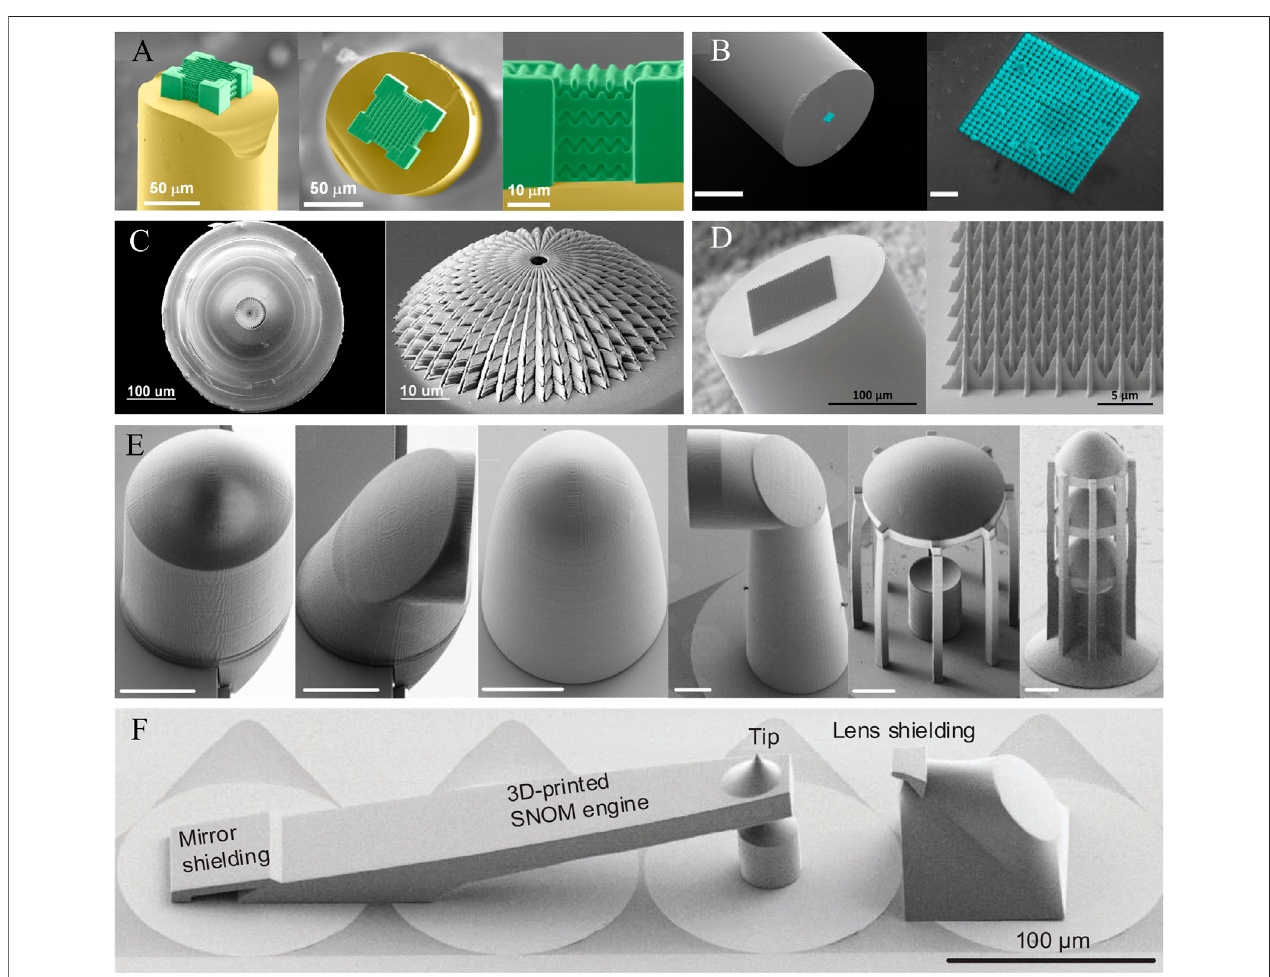
FIGURE 3 | Optical fi ber integrated polymer micro-optics printed by TPP. (A) Woodpile photonic crystal structure printed on the SMF (Williams et al., 2011). (B) Microstructuredgradient-indexantire fl ectivecoatingprintedontheSMFforreducetheFresnelre fl ection(Kowalczyketal.,2014). (C) 3DSERSradarstructureprintedon MMF(Xieetal.,2015). (D) FiberSERSprobewithcrossspikearrayforrapiddetectionoflivebacteria(Kimetal.,2020). (E) Free-formlenses,free-formmirrorsandbeam expanders for the coupling between the optical fi ber end face and the chip interface (Dietrich et al., 2018). (F) Scanning-probe microscope (SPM) with integrated optical actuation and read-out based on fi ber array (Dietrich et al.,